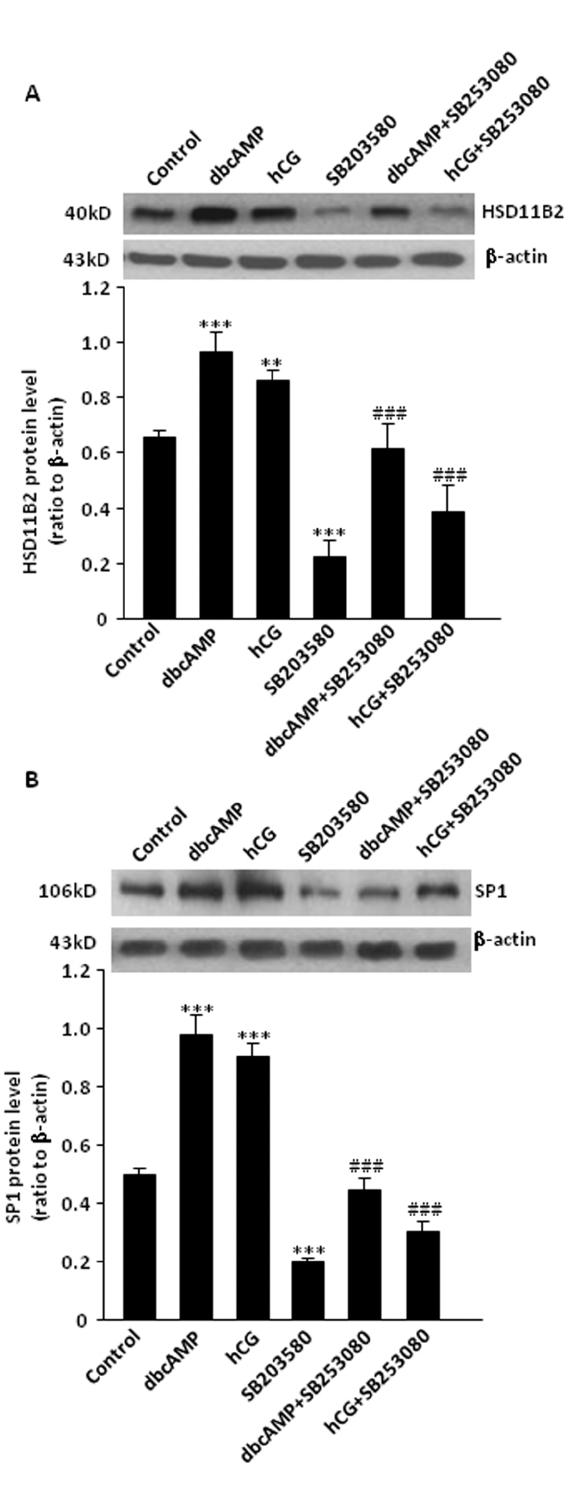
Figure 3. (A) Effect of SB203580 (p38 MAPK inhibitor, 10 m M) on the basal and dbcAMP (100 m M) and hCG (10 IU/ml)- induced HSD11B2 protein level in human placental syncytio- trophoblasts. *p , 0.05, **p , 0.01, ***p , 0.001 versus control; ## p , 0.01 ### p , 0.001 versus treatment with dbcAMP and hCG, n=4. (B) Effect of SB203580 (p38 MAPK inhibitor, 10 m M) on the basal and dbcAMP, 100 m M) and hCG (10 IU/ml)-induced SP1 protein level in human placental syncytiotrophoblasts. ***p , 0.001 vs control;